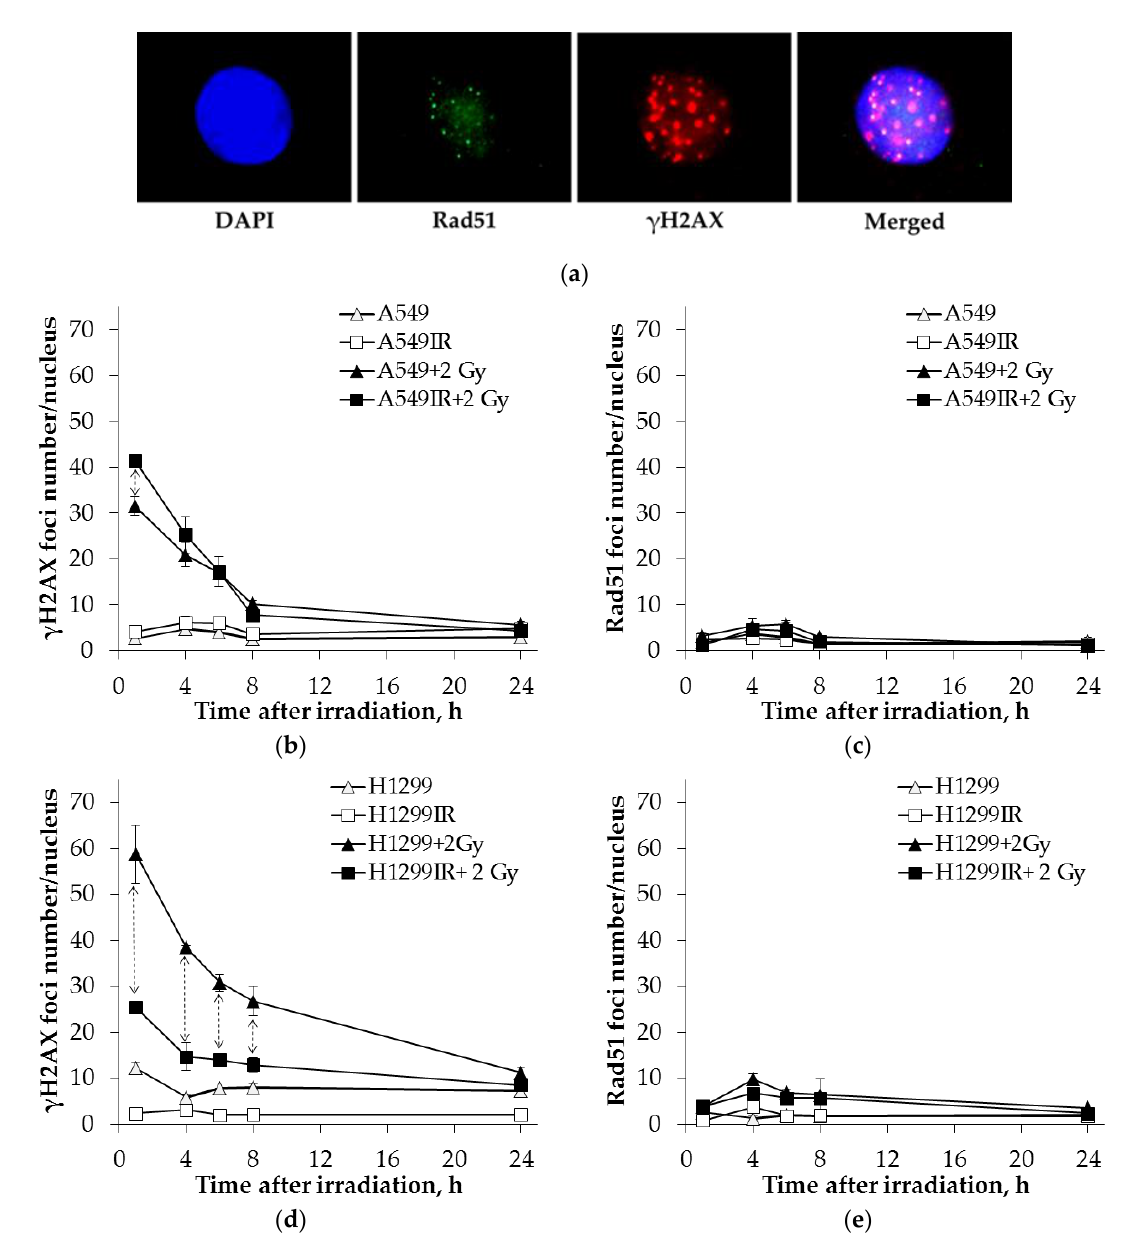
Figure 2. Kinetics of γH2AX and Rad51 foci changes in A549 and A549IR cells and H1299 and H1299IR cells after 2 Gy X-ray exposure. Representative immunofluorescent images of the irradiated cells showing Rad51 (green), γH2AX (red) foci and their colocolization (Merged). DAPI nuclear counterstaining is shown in blue ( a ). Comparative analysis of changes in the number of γH2AX foci in A549 and A549IR ( b ) and H1299 and H1299IR cells ( d ) after 2 Gy X-ray exposure; changes in the number of Rad51 foci in A549 and A549IR cells ( c ) and H1299 and H1299IR cells ( e ) after 2 Gy X-ray exposure. ↕ denotes significant differences between groups at p < 0.05. Data are means ± SD of three independent experiments.